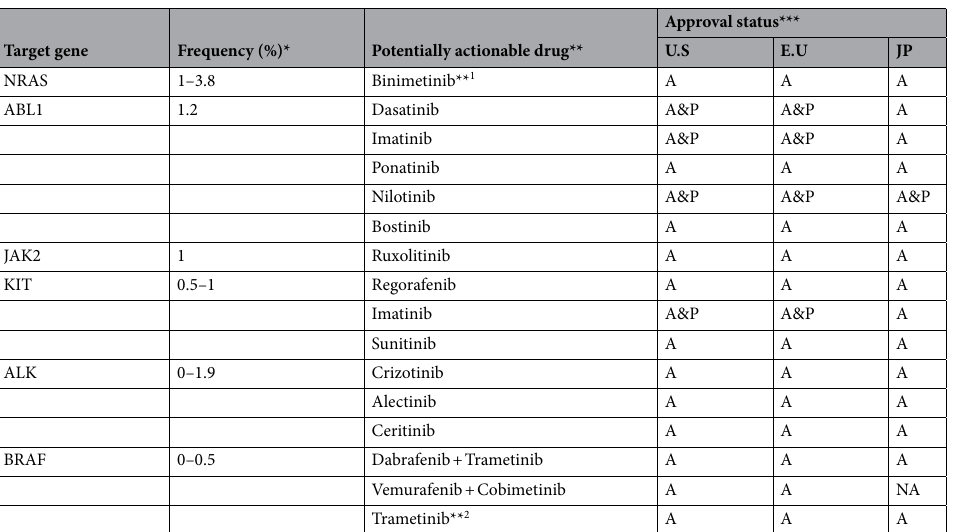
Table 2. Targeted genes and candidate drugs with high priority for development of pediatric indication. U.S. United States. E.U. = European Union; JP Japan; A Adult indication; A&P Adult and pediatric indications; NA Not approved for either adults or children. * Frequency of genomic abnormalities in childhood cancers. ** Not only for the primary target. Drugs with clinical evidence were listed according to the reference data base. ** 1 A MEK inhibitor which has clinical evidence for NRAS mutations. ** 2 A MEK inhibitor which has clinical evidence for BRAF alterations. ***Approval status as of February